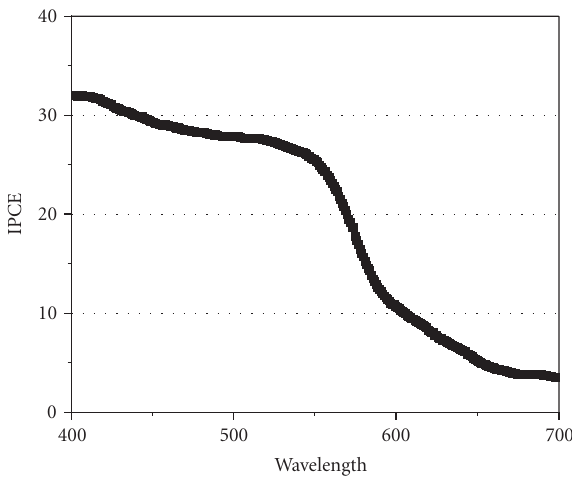
Figure 7: IPCE of device used TiO 2 /G-PEDOT nanocomplex as